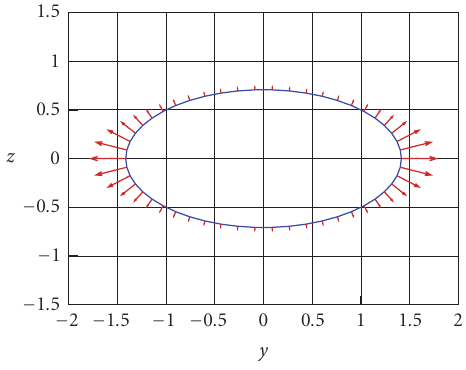
Figure 6.7. Normal stress ( T nn n y + T nn n z ) / 50dyn/cm 2 for an ellipse y 2 /b 2 + z 2 /c 2 = 1 − 1 . 0 2 /a 2 at x = 1 . 0 cm in the ( y , z )-plane. Perpendicular view of the cross section (f) in Figure 6.1. There is a change of sign of the normal stress right after the front half of the ellipsoid. It changes from negative (compression) to positive (tension). Strong tension near the right and left poles and mild tension towards the center. This may induce the formation of a flat tail for a gas bubble. The same e ff ect is observed in the other cross sections of the rear part of the ellipsoid (see Figures